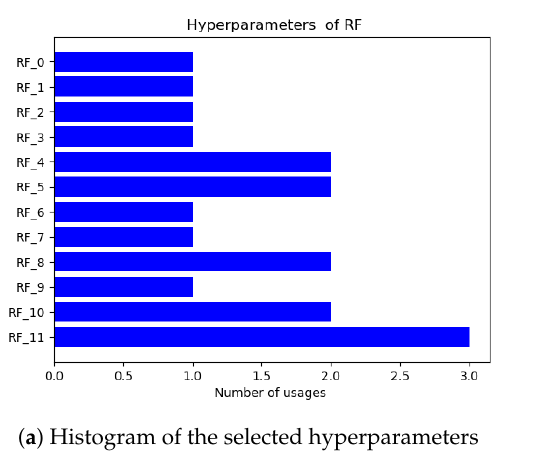
Figure 17. Histogram of the selected hyperparameters of the magnetic